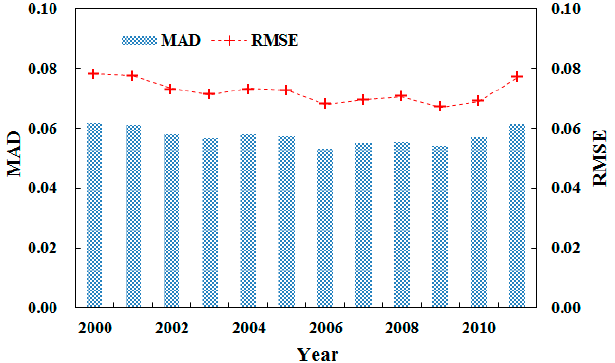
Figure 4. Inter-annual variation of the mean root-mean-square error (RMSE) and mean absolute difference (MAD) for the fusion method.